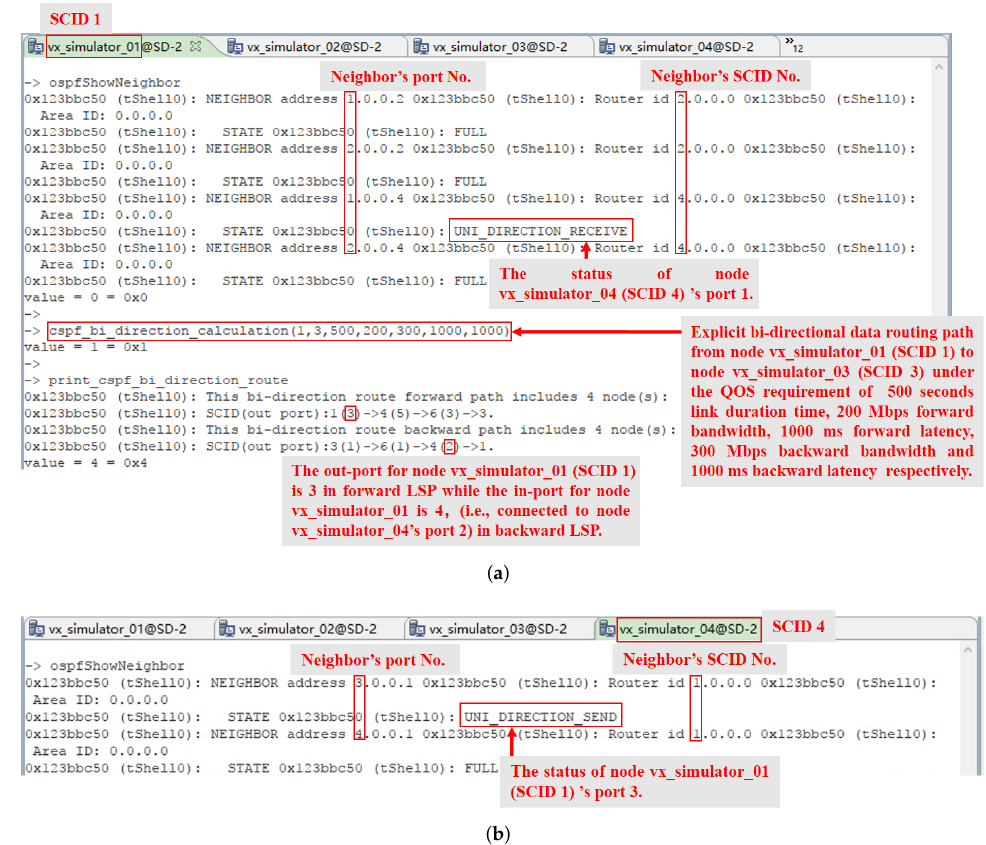
Figure 12. Simulation in the software platform with 16 simulated nodes under the circumstances of uni-directional link. ( a ) The status of a neighbor’s ports and explicit constraint routing path for data under QoS requirements in node vx_simulator_01 (SCID 1). ( b ) The status of a neighbor’s ports in node vx_simulator_04 (SCID 4).